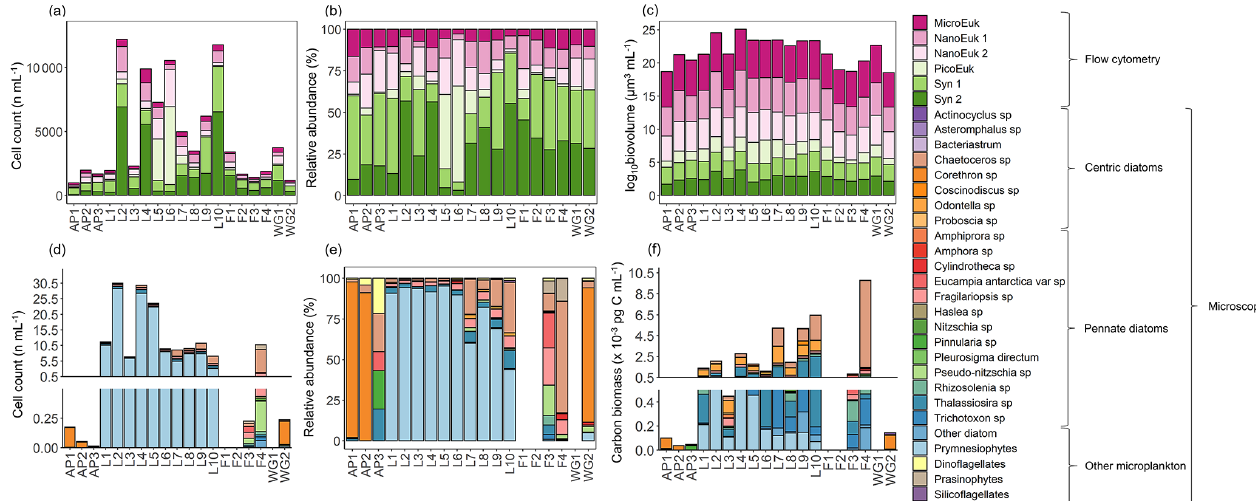
Figure 9. The (a, d) cell counts, (b, e) relative cell abundances, (c) log-transformed biovolume, and (f) carbon biomass of all phytoplankton groups identified from (a–c) surface flow cytometry samples and (d–f) plankton net-tow samples. The stations are labelled on the x axis. Where there are no bars in panels (d) , (e) , and (f) , no data are available. Carbon biomass estimates in panel (f) are shown only for the prymnesiophyte, P. antarctica , and the diatom